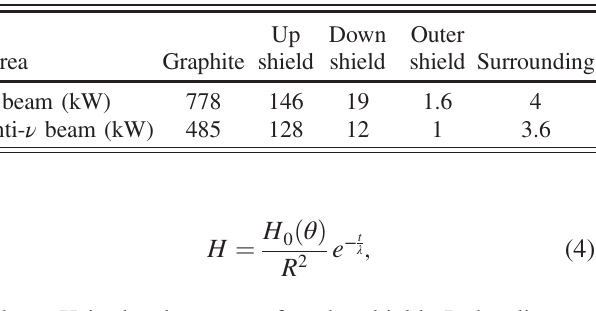
TABLE VI. Energy deposition in kW for the decay tunnel iron shield, iron vessel, and surrounding concrete.